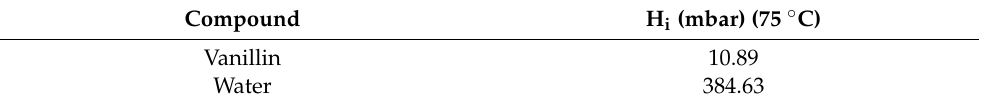
Table 7. Values of the calculated Henry constants of vanillin and water at 75 ◦ C.